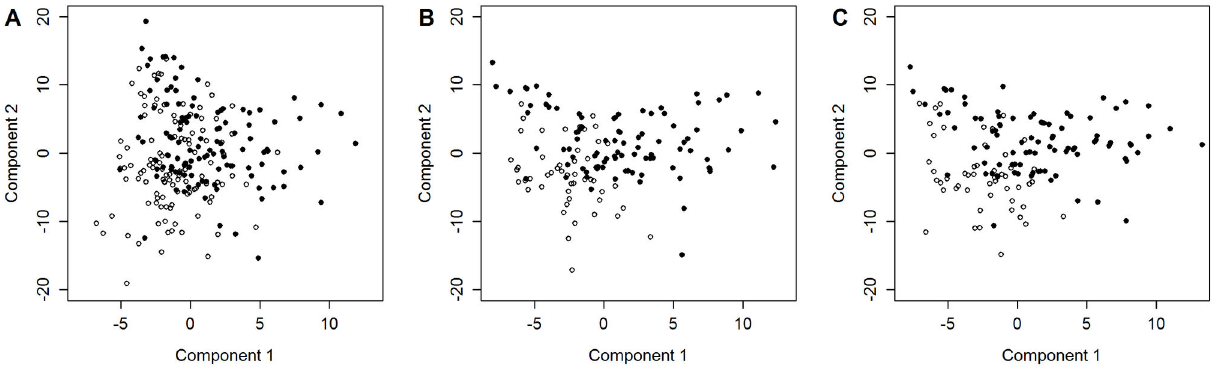
Figure 2. Scatter plots of the first two components of partial least-squares discriminant analyses (PLS-DA) of. fatty liver disease (FLD) . FLD was defined ( A ) by ultrasound and more stringent ( B ) by ultrasound and elevated ALT level and ( C ) by ultrasound and the presence of the metabolic syndrome (MetS). PLS-DA components were obtained for 138 serum metabolite concentrations in ( A ) 230 individuals (115 cases, 115 controls), ( B ) 144 individuals (51 cases of fatty liver disease with elevated ALT level, 93 controls with normal ALT level) and ( C ) 140 individuals (51 cases of fatty liver disease and MetS, 89 controls without MetS), respectively. In the three models the first two components explained ( A ) 22.5% (16.1% and 6.4% respectively), ( B ) 42.4% (20.1% and 22.3%) and ( C ) 37.7% (18.7% and 19.0%) of the variation in the response (case-control status). Open circles : cases; filled circles : controls. doi: